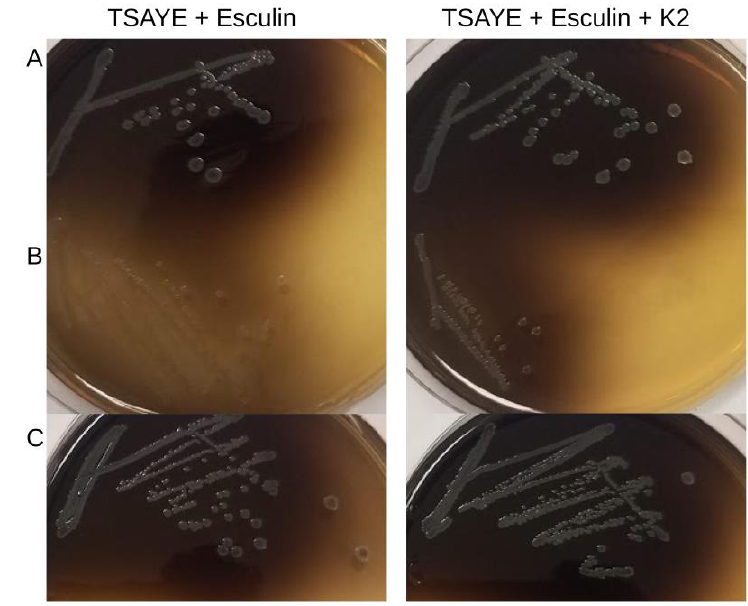
Figure 3. Impact of the transposon insertion in lmo1930 on colony size and esculin hydrolysis of L. monocytogenes , and effects of K2 supplementation. Cultures were grown on media with esculin / ferric ammonium citrate (TSAYE-Es) (left) or TSAYE-ES with vitamin K2 (right) as described in Materials and Methods. Panels: A, parental strain 2010L-1723; B, mariner-based mutant H1H3; C, H1H3 complemented with the lmo1930 homolog. Strains were grown at 37 °C for 24 h (top) and 48 h (bottom).